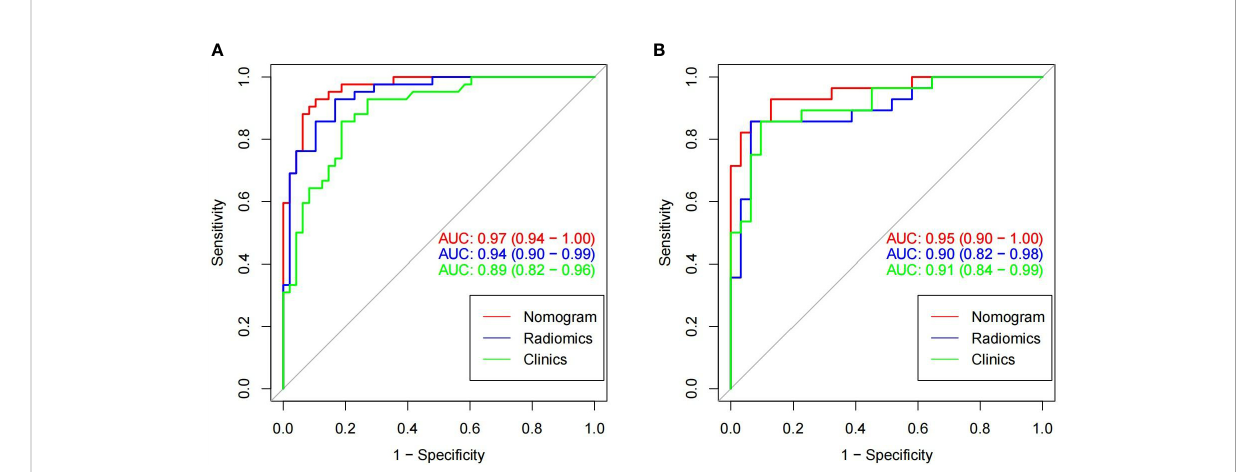
FIGURE 6 In the training cohorts (A) and validation cohorts (B) , two images showing ROC curves and AUC values of the combined radiomic-clinical model, the radiomic model and clinical model. In both the training and validation groups, the AUC value of the combined model was higher than the clinical and radiomic